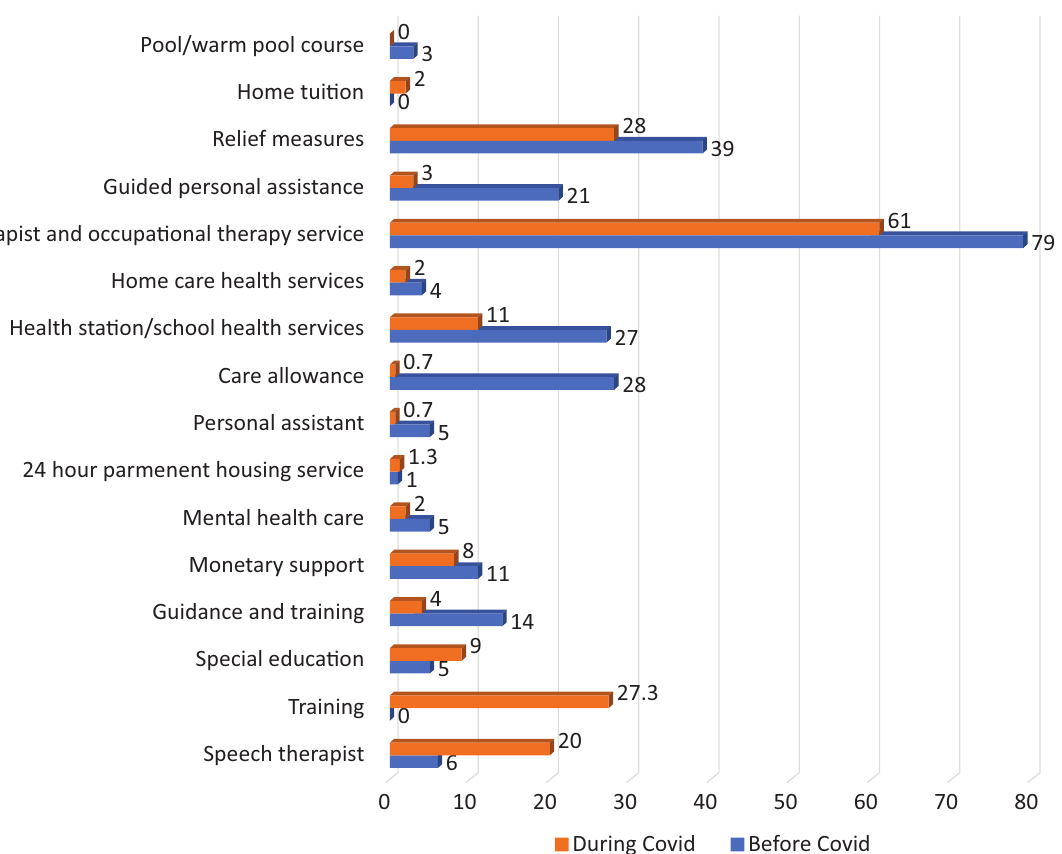
Figure 2. The level of access of children with disabilities to different kinds of social welfare before and during the pandemic in percentage (N =